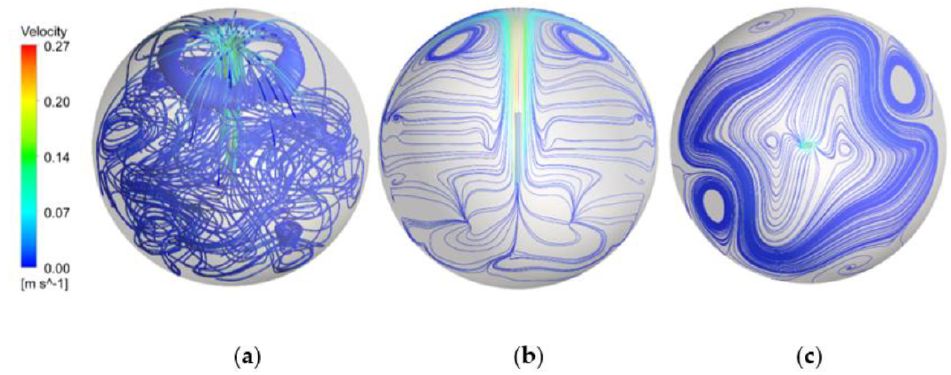
Figure 6. Streamline in the spherical cavity (( a ): 3D sphere, ( b ): Section z = 0, ( c ): Section y =